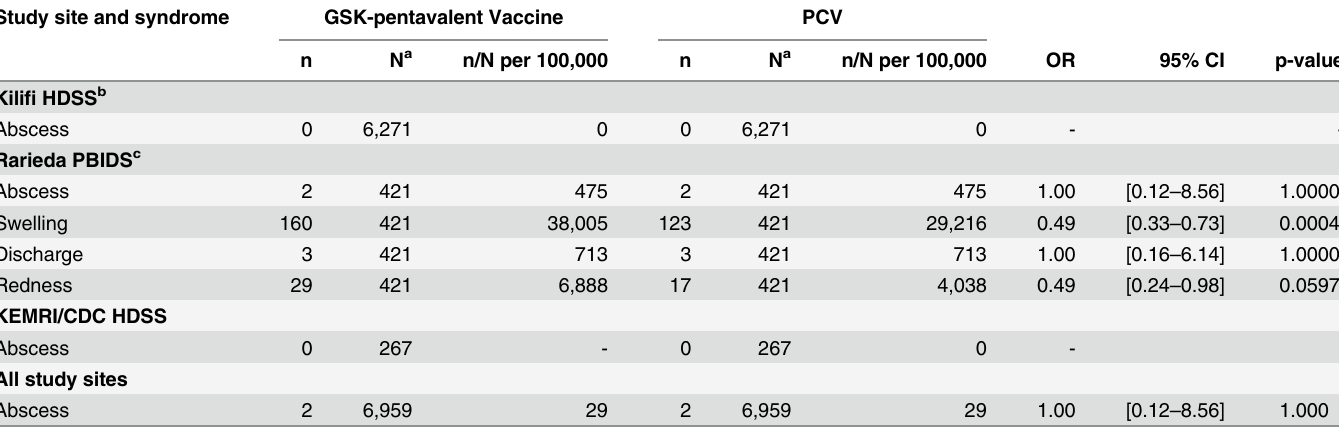
Abbreviations: CDC, Centers for Disease Control and Prevention; CI, con fi dence interval; GSK, GlaxoSmithKline; HDSS, Health and